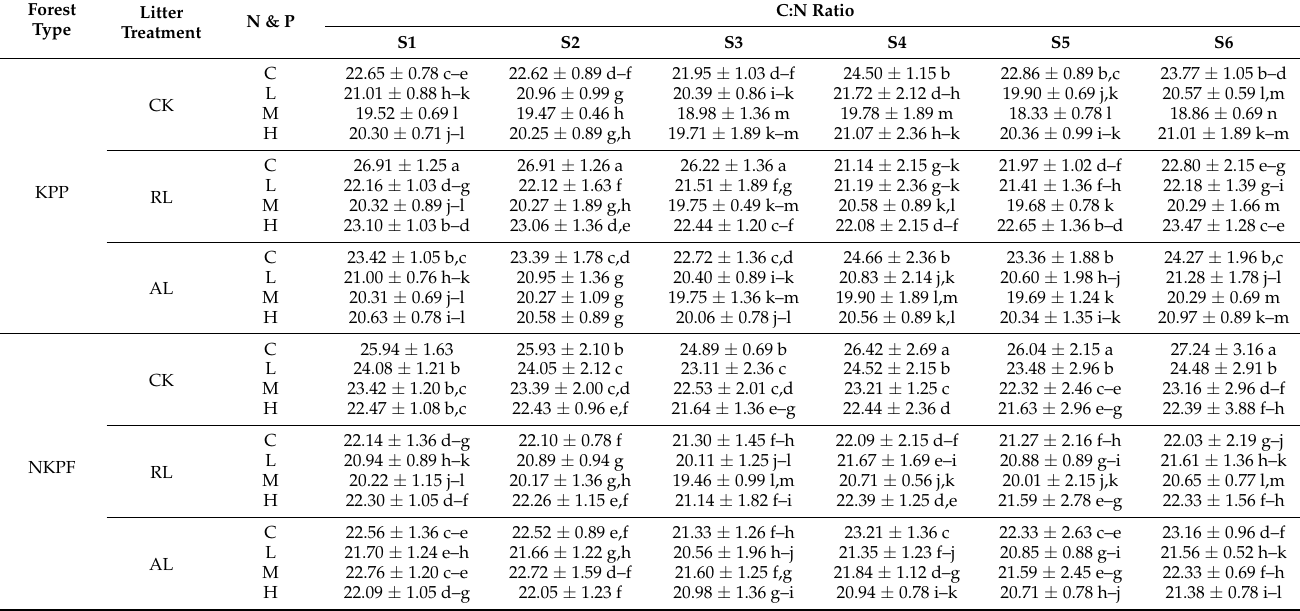
Table 3. Changes in carbon to nitrogen ratio by N and P inputs along with litter treatments across six